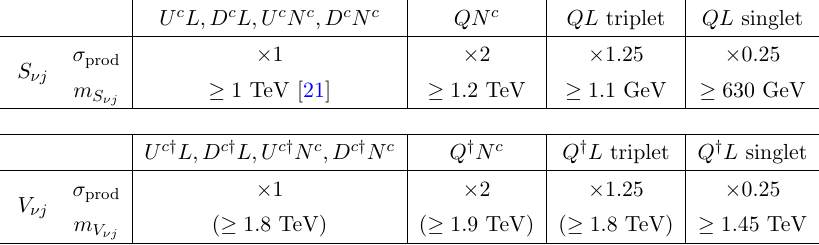
(cid:23)j obtained from (cid:12)gure 8.